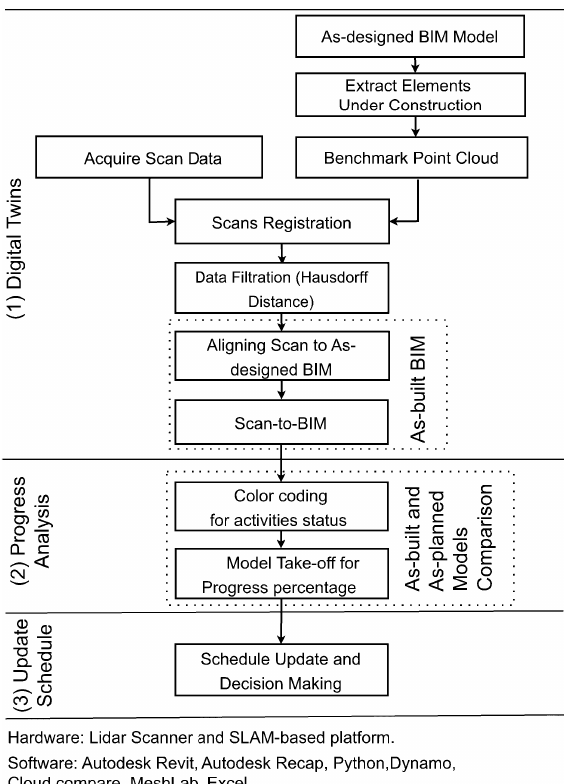
Figure 1. Proposed research framework for monitoring progress of construction projects.